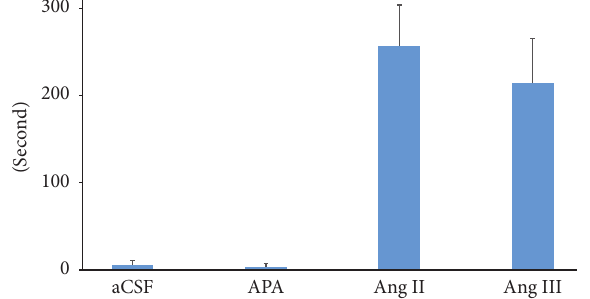
Figure 3: Duration of drinking time after intracerebroventricular (icv) administration of angiotensin (Ang) II, Ang III, or aminopep- tidase A (APA). Duration of drinking time was measured after icv administration of aCSF, 25 ng of Ang II, 25 ng of Ang III, or 800 ng of APA. This dose of Ang II or Ang III evoked similar pressor response to 800 ng of APA. After icv administration of CSF, drinking behavior was not observed; after icv administration of Ang II and Ang III, continuous drinking behavior was observed; after icv administration of APA, drinking behavior was not observed. Values are expressed as mean ±